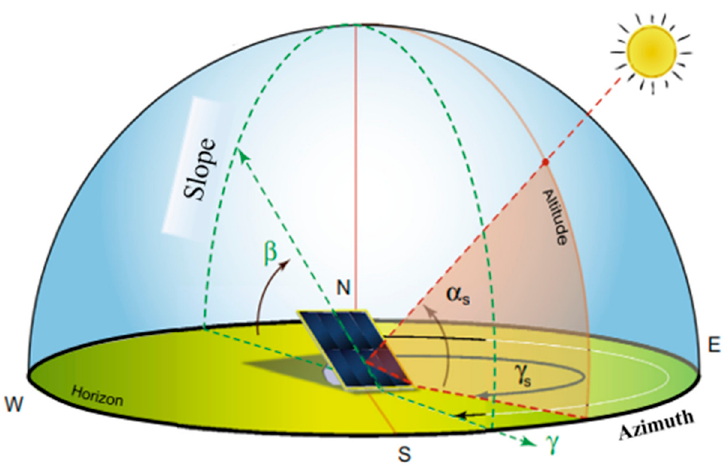
Figure 10. Factors affecting the performance of solar PV panels [87]. In particular, the electrical energy resulting from the transformation of the solar energy absorbed by the panels is strictly related to the slope (the tilt angle) and the azimuth angle [88]. The tilt angle (elevation angle) represents the angle formed by the